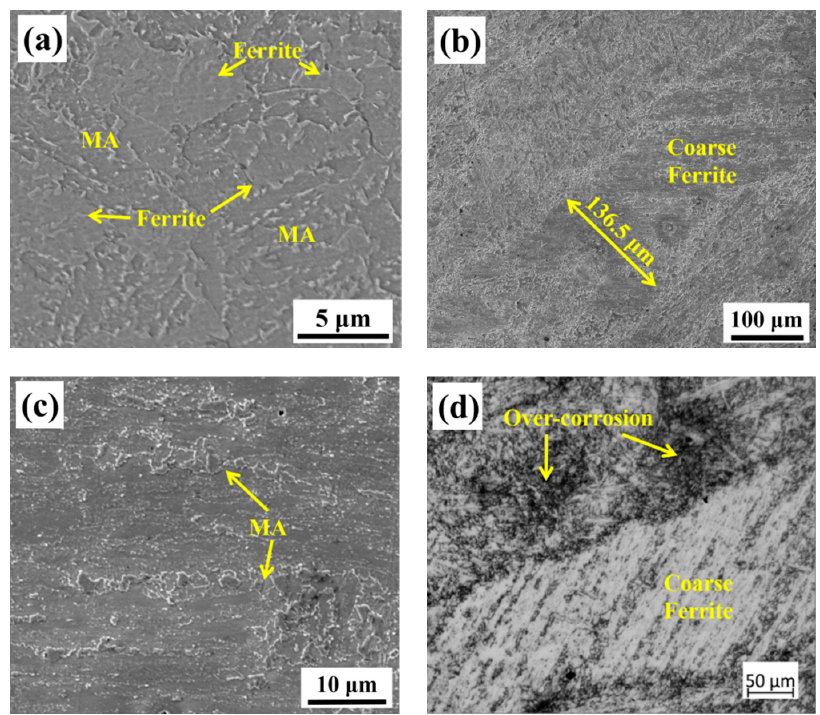
Figure 8. Microstructure of cross-section in Figure 3a for as-welded specimen ( a ), and for PWHT specimen ( b–d ).